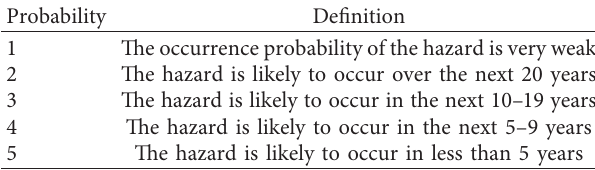
Table 4: Ranking the level of